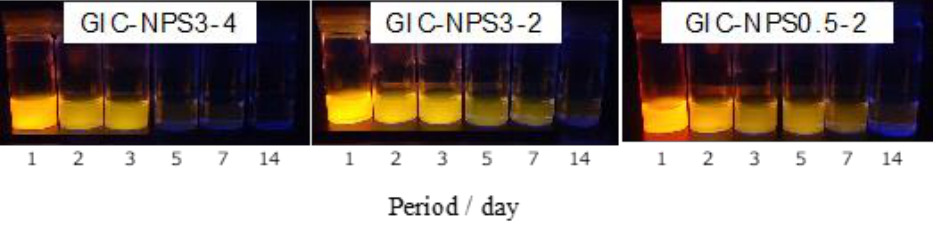
Figure 1. Photo images under ultraviolet light of each supernatant in which GIC–NPS3-4, GIC–NPS3-2, or GIC–NPS0.5-2 were immersed for different periods.